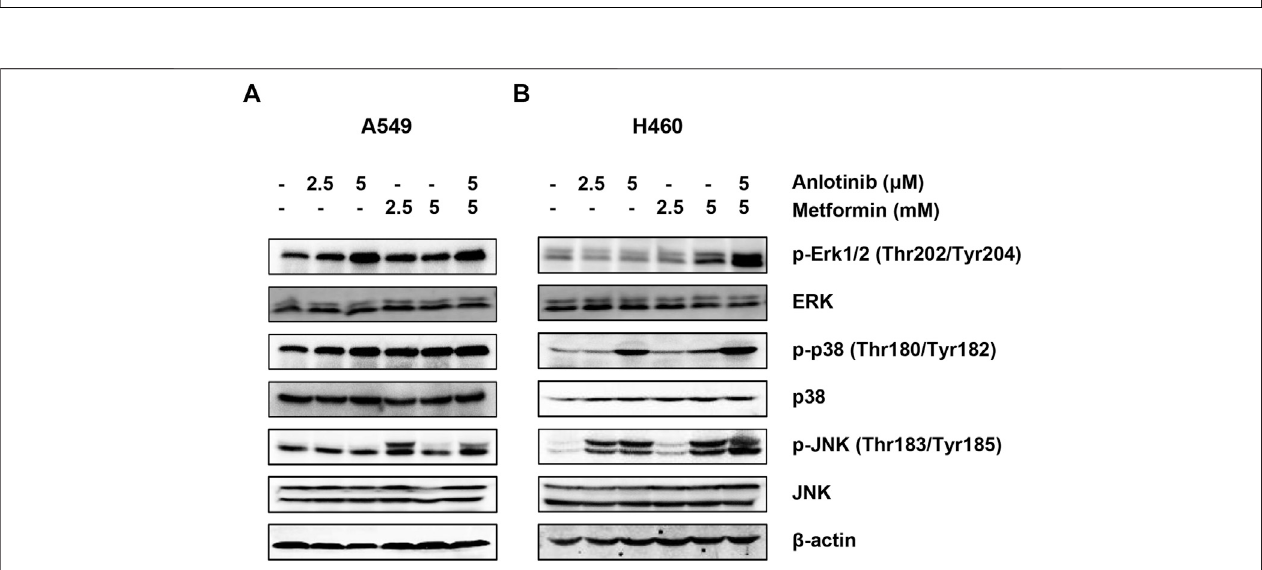
FIGURE 6 | Anlotinib combined with metformin increases the phosphorylation of ERK1/2, p38, and JNK. A549 (A) and H460 (B) cells were incubated with the indicated concentrations of anlotinib, metformin, or both for 24 h. Cell lysates were immunoblotted with antibodies against pERK1/2 and ERK1/2, p-p38 and p38, and pJNK and